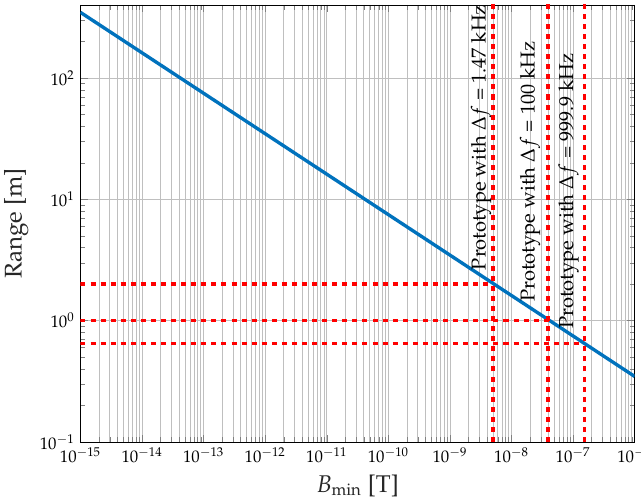
Figure 7. Transmission range as a function of the magnetic field detection limit of the detector. Parameters are taken from Table 2. The maximum transmission distance based on the prototype implementation detection threshold is marked for three different bandwidths. The transmission range can be increased by using a more sensitive type of